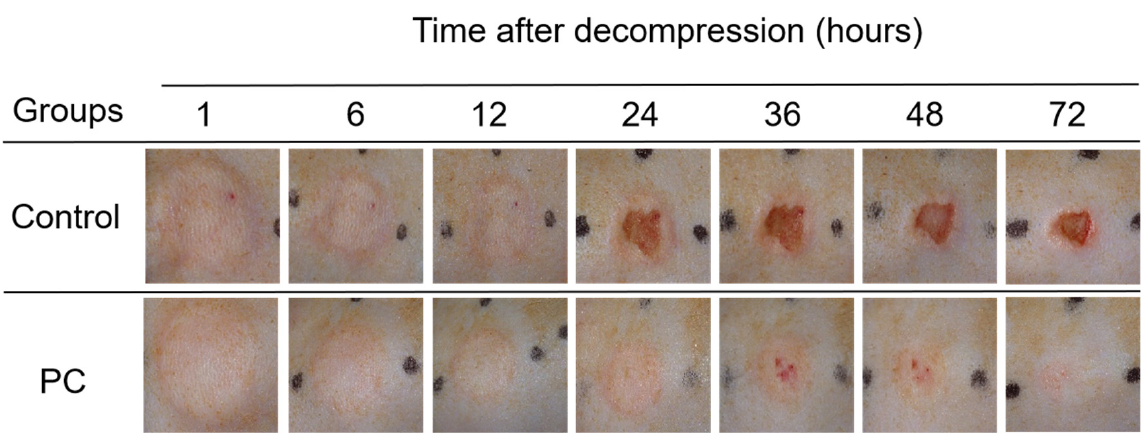
Figure 1. Photographs of PI wounds in two groups from 1 to 72 h after decompression. PI: pressure injury. PC: preconditioning.